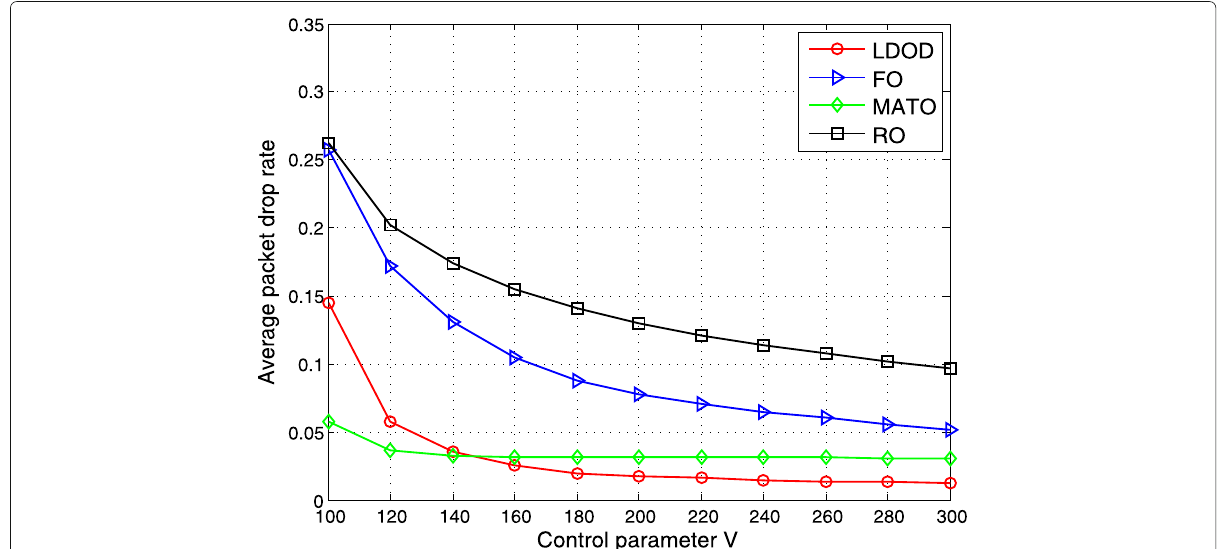
Fig. 13 The average packet drop rate versus V with the proposed algorithm, MATO algorithm, and RO and FO algorithm